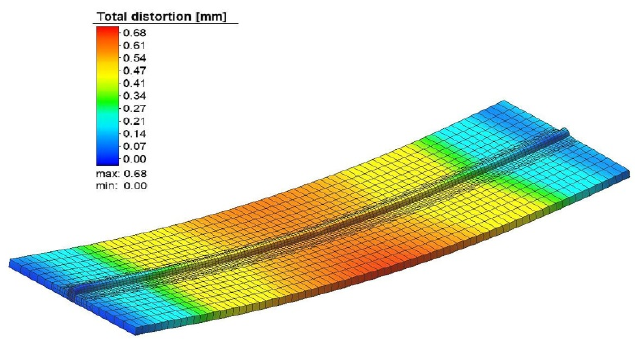
Figure 11. The total distortion at the optimum point.